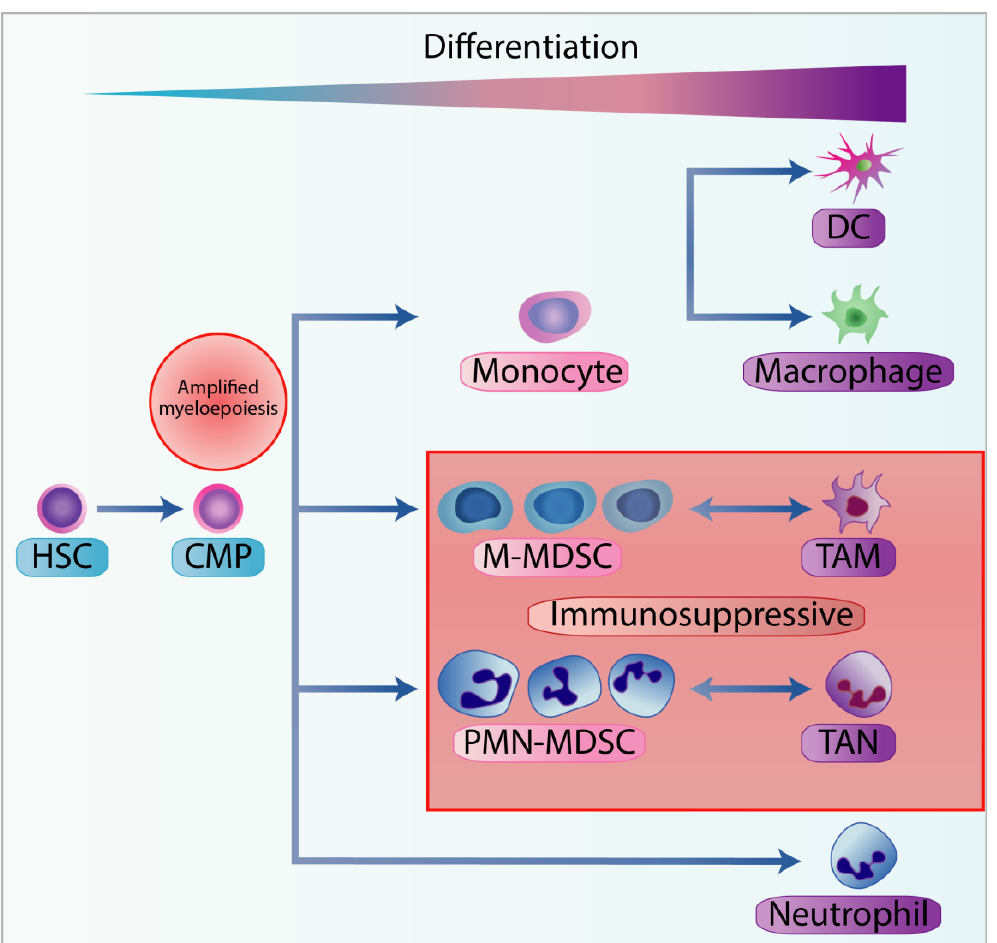
Figure 3. Stages of myelopoiesis differentiation in cancer. Myelopoiesis is amplified during chronic inflammation to assist tumour progression and dissemination. The hematopoietic stem cells (HSC) differentiate into the common myeloid progenitor (CMP), which can further differentiate through the hematopoietic system. In physiological conditions, CMP can differentiate into neutrophils or into monocytes, and subsequently into dendritic cells (DC) or macrophages. However, with chronic inflammation, pro-inflammatory cytokines can skew the monocytopoiesis of CMP into monocytic-myeloid-derived suppressor cells (M-MDSC) and tumour-associated macrophages (TAM), and granulopoiesis into polymorphonuclear myeloid-derived suppressor cells (PMN-MDSC) and tumour-associated neutrophils (TAN).